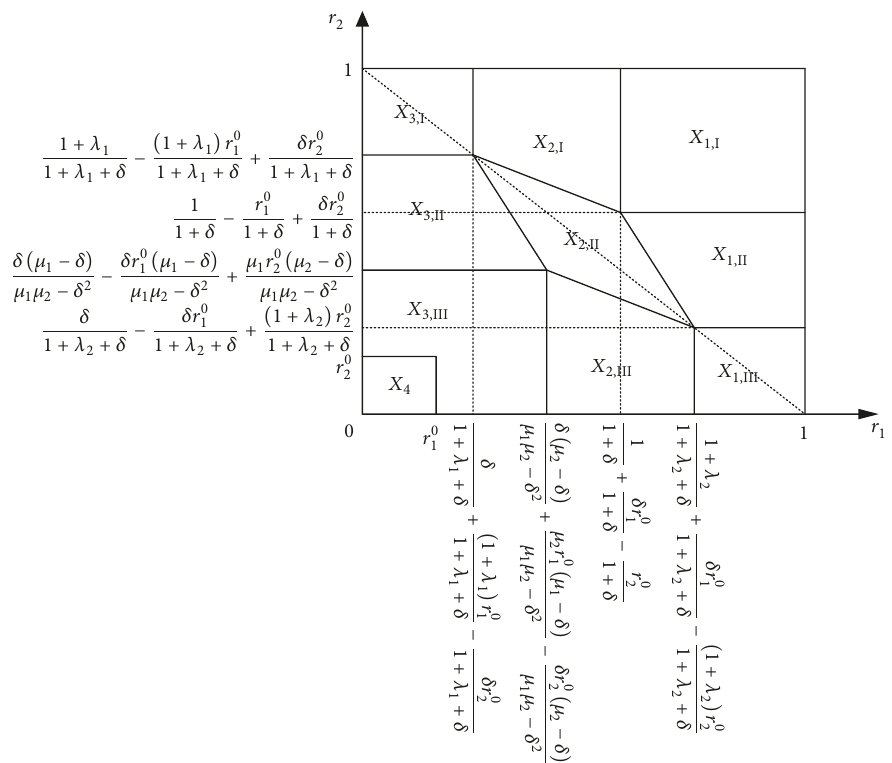
Figure 1: The partition 𝑋 1, I ,......,𝑋 3, III ,𝑋 4 , where 𝑋 4 represents the set of the initial reference